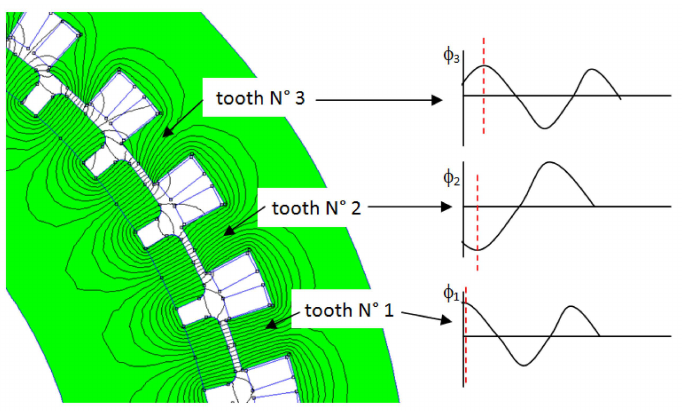
Figure 5. Partial view of the structure having 40 poles 36 slots; in a group of three adjacent teeth, the magnetic flux cannot be the same at each